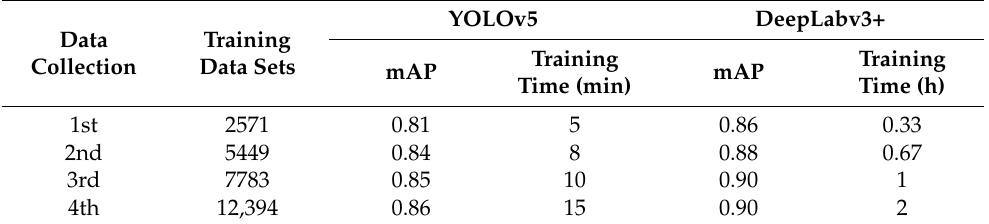
Table 11. The mAP results of YOLOv5 and DeepLabv3+ by data collection period for B3.